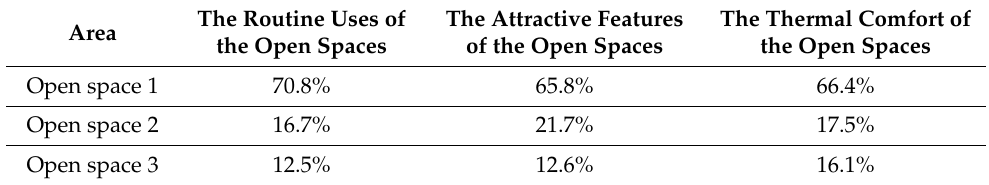
Table 7. Summary of students’ satisfaction based on their experience of the three open spaces. The Routine Uses of The Attractive Features The Thermal Comfort of Area the Open Spaces of the Open Spaces the Open Spaces Open space 1 70.8% 65.8% 66.4% Open space 2 16.7% 21.7% 17.5% Open space 3 12.5% 12.6%